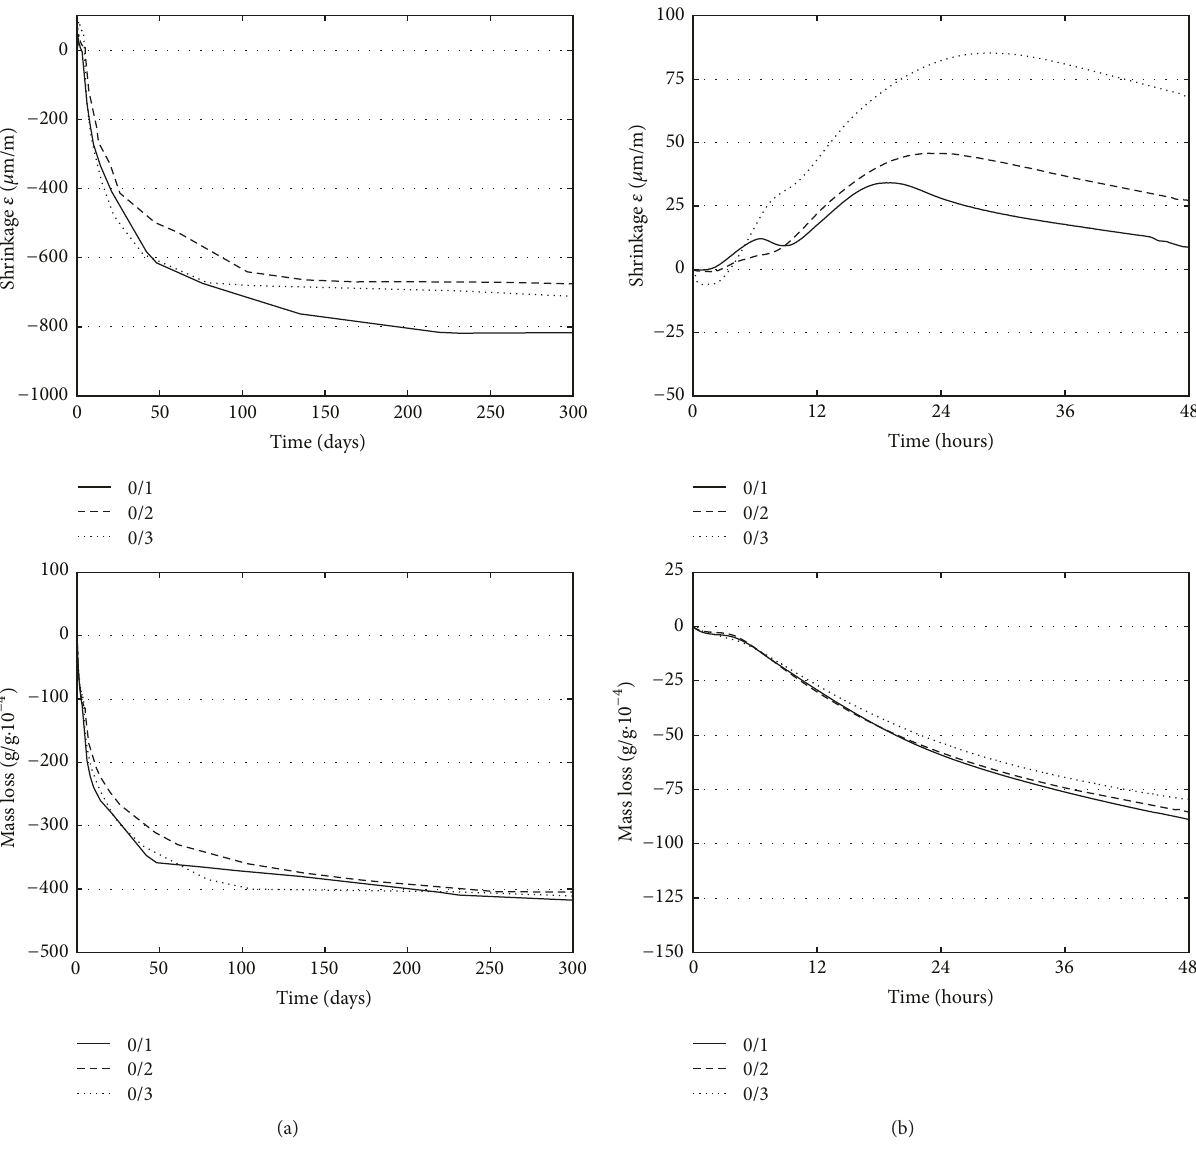
Figure 4: Progress of shrinkage/swelling and mass loss for concrete 0/1, 0/2, and 0/3 ((a): measurement over the whole time of setting and hardening; (b): early age